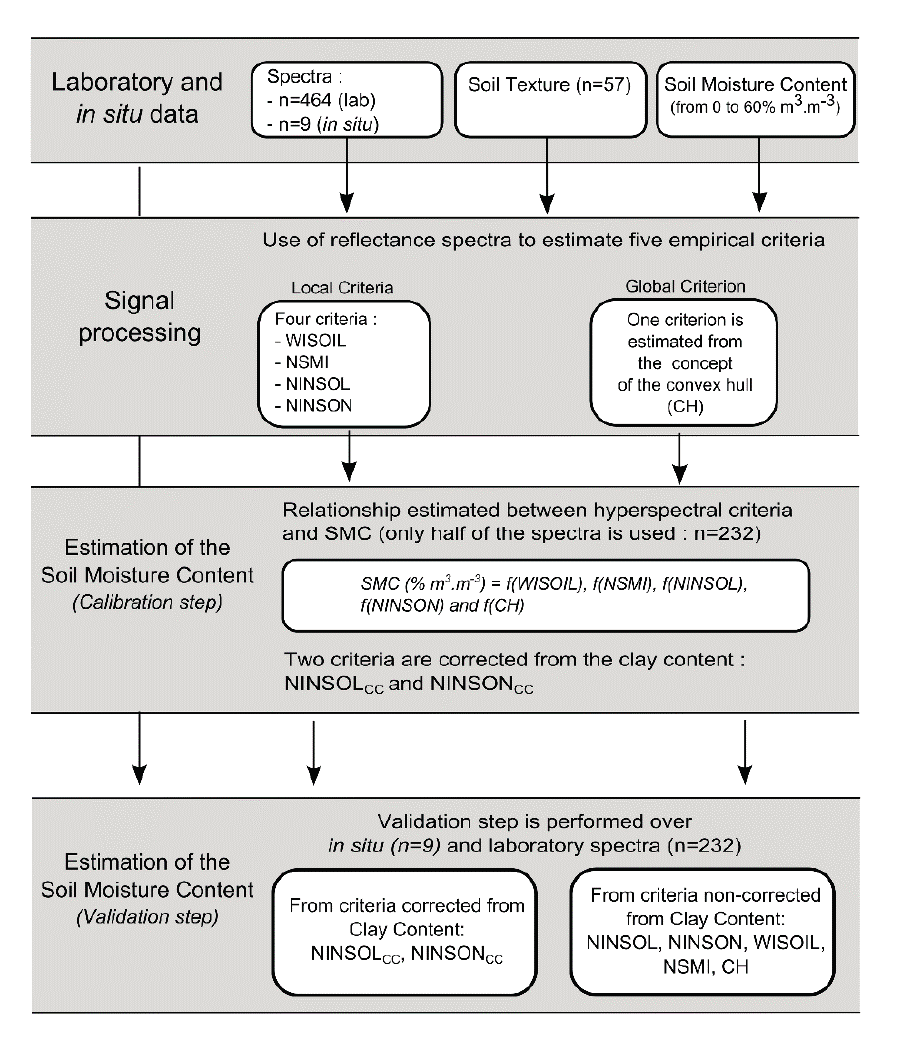
Figure 5. Flowchart showing the different methods used to estimate the volumetric soil moisture content from hyperspectral